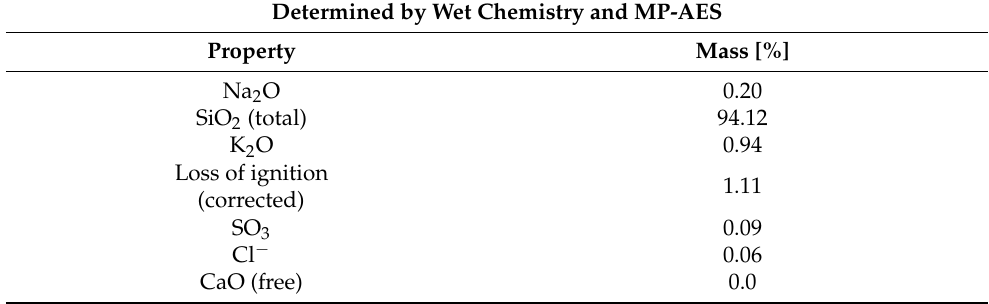
Table 2. Mineralogical composition of the employed silica